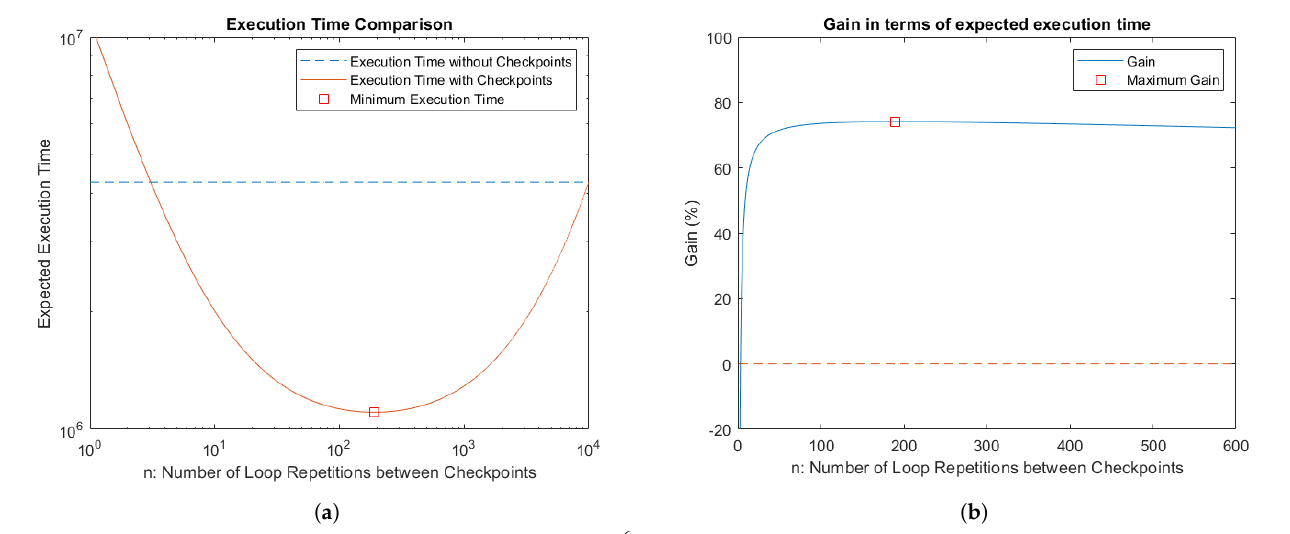
Figure 3. The case of a large software program (i.e., Y = 10 6 ): ( a ) Expected execution time comparison (logarithmic axes) ( b ) Expected execution time